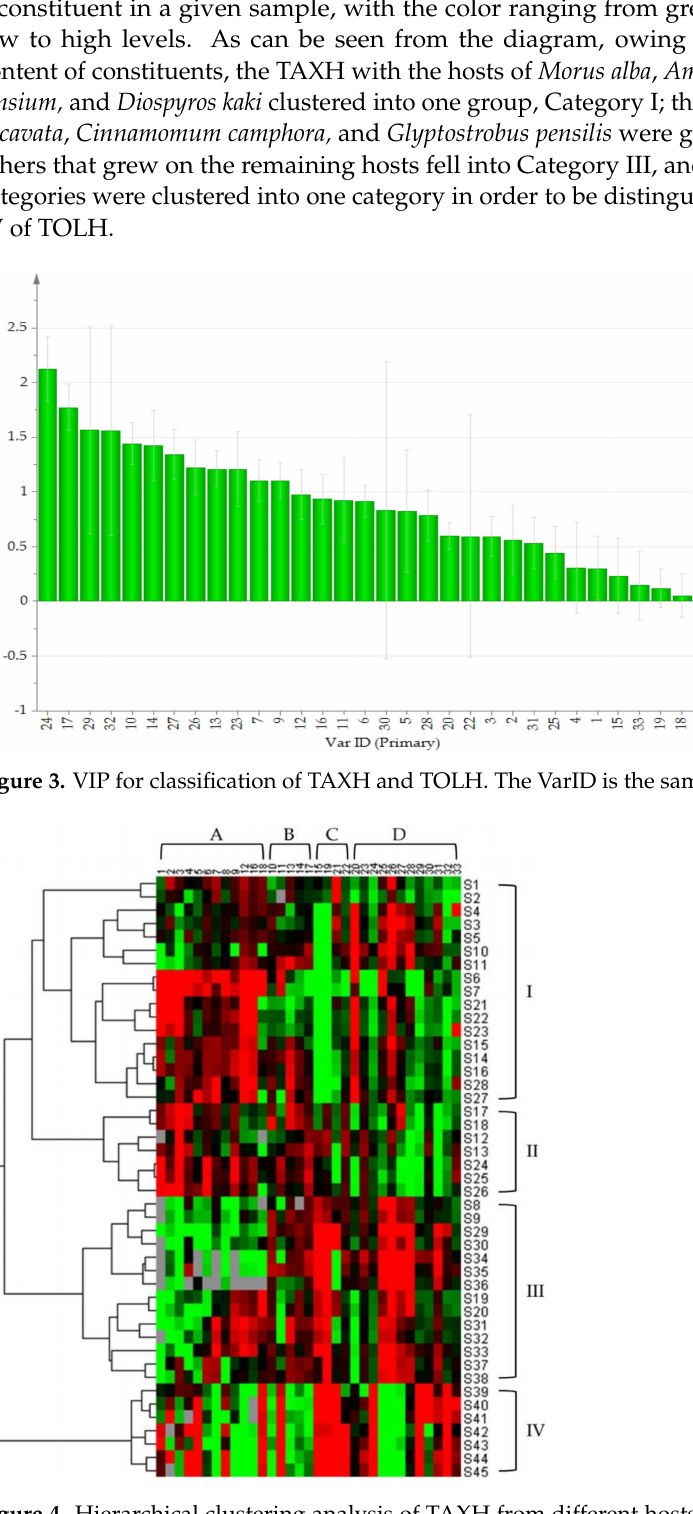
Figure 4. Hierarchical clustering analysis of TAXH from different hosts and TOLH. The heatmap shows the content difference of 33 constituents. The green color represents the decreasing trend, the red represents an increasing trend. A total of 45 samples were divided into 4 categories, which were Category I, Category II, Category III, and Category IV. (Amino acids ( A ), Nucleosides ( B ), Organic acids ( C ), Flavonoids ( D